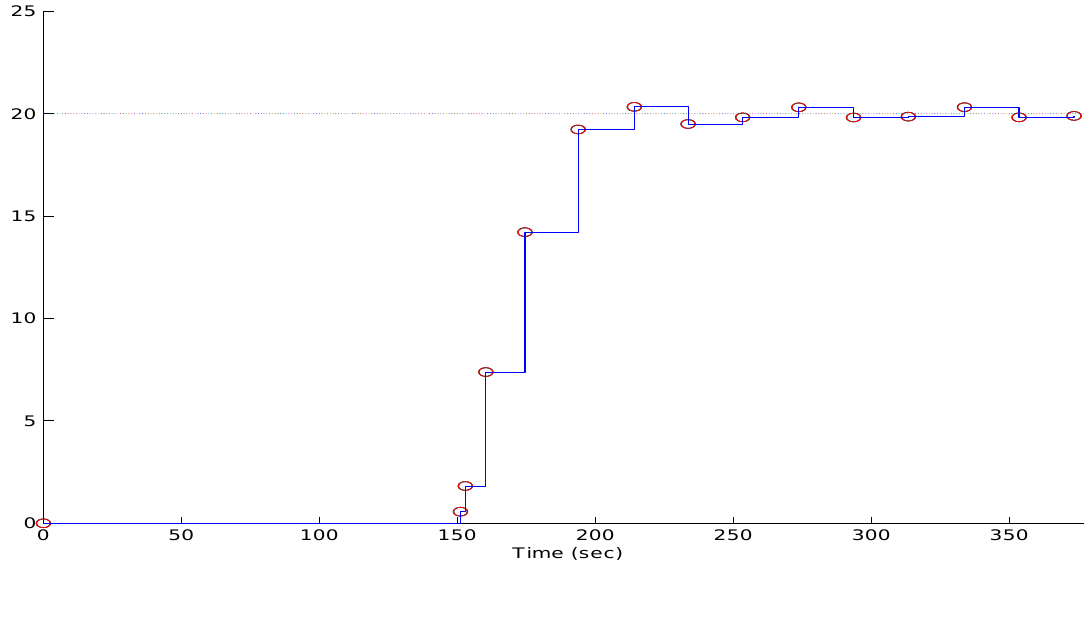
Figure 15 . Measured Time Delay for transmitting an image frame over experimental time (Initial values R = 0 : 3 , T d = 20 s, and (cid:22) = 0 : 01